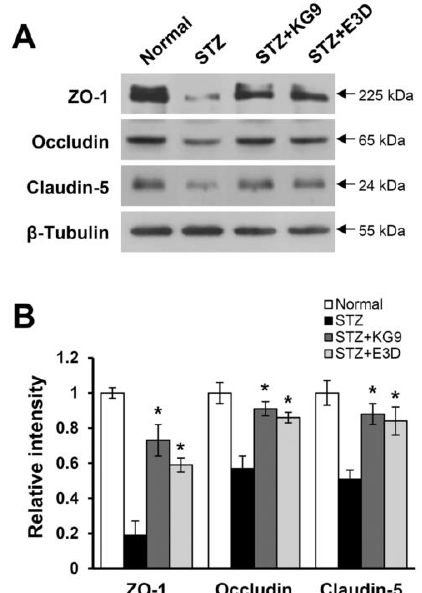
Figure 5. GS-KG9 and GS-E3D alleviate the loss of tight junction proteins in the hippocampus of STZ-induced diabetic rats. Brain tissue and hippocampal extracts from rats treated with GS-KG9 and GS-E3D (300 mg / kg) at 28 d after drug treatment were prepared as described in the Materials and Methods section ( n = 3 rats / group). ( A ) Western blots for ZO-1, occludin, and claudin-5. ( B ) Quantitative analysis of the Western blots. Data are presented as the mean ± SD. * p < 0.05 vs. STZ control.